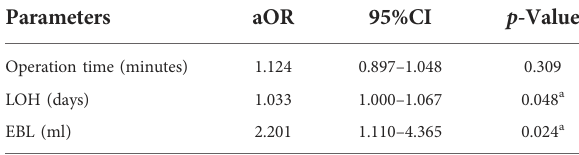
TABLE 4 Multivariate logistic regression analysis of OLF with